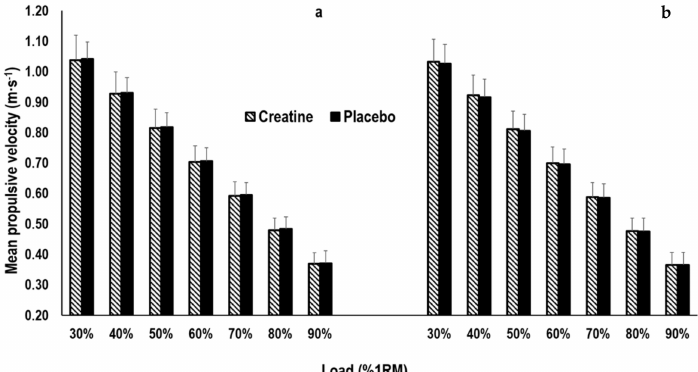
Figure 3. Changes in the load–velocity profile for the creatine and placebo condition pre ( a ) and post ( b ) of the 7–day supplementation period. %1RM = relative load of one repetition maximum.